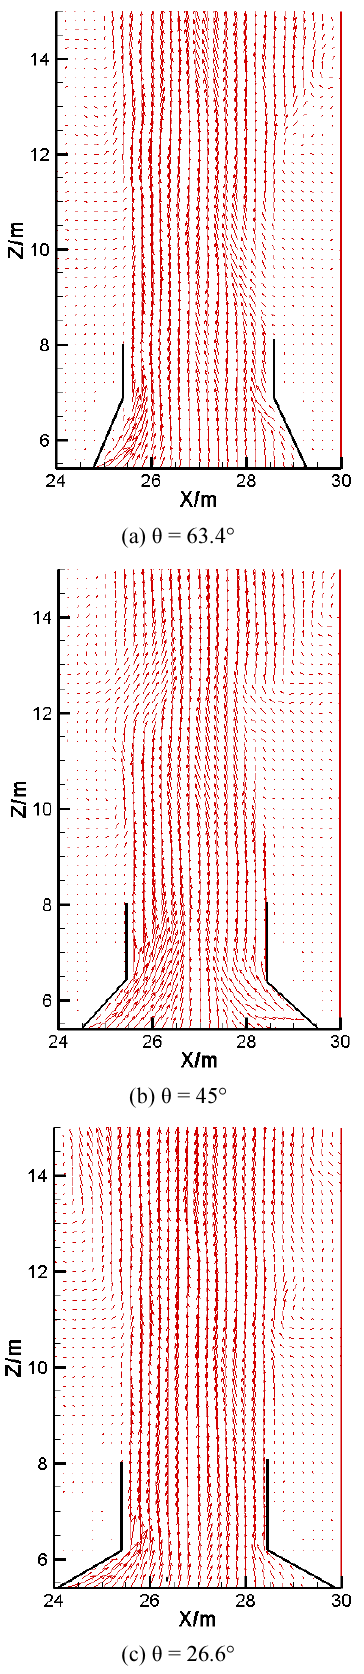
Fig. 11. Velocity vector field in the shaft (the shaft height is 2.6 m)